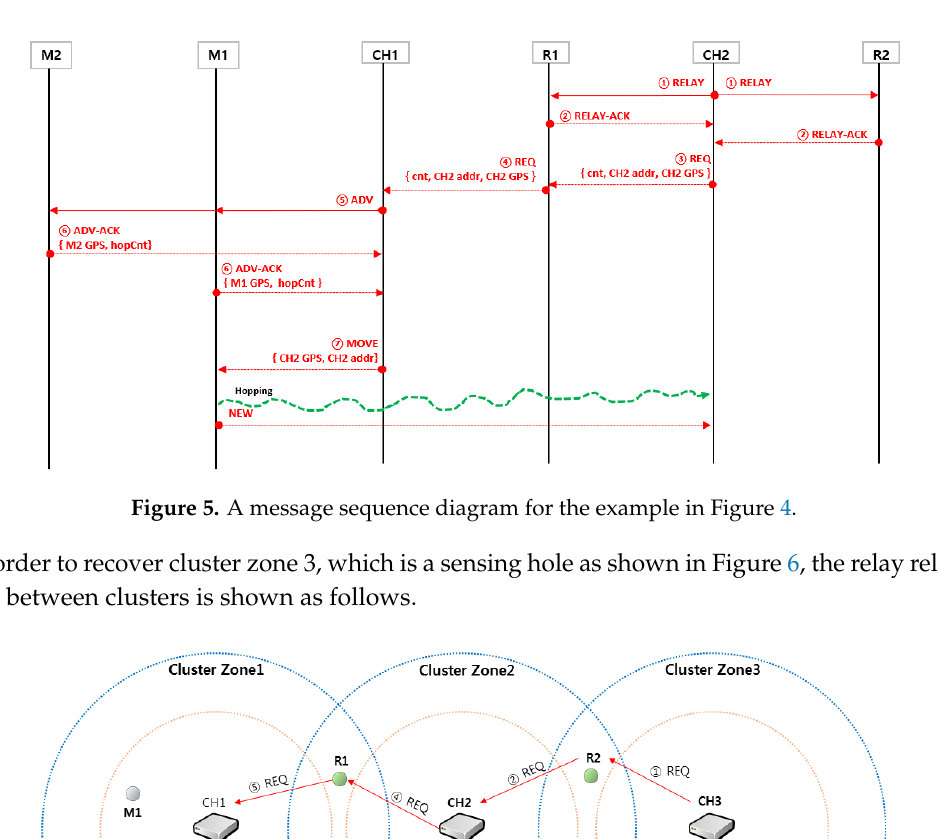
Figure 4. An example of hopping sensor relocation through the proposed protocol.